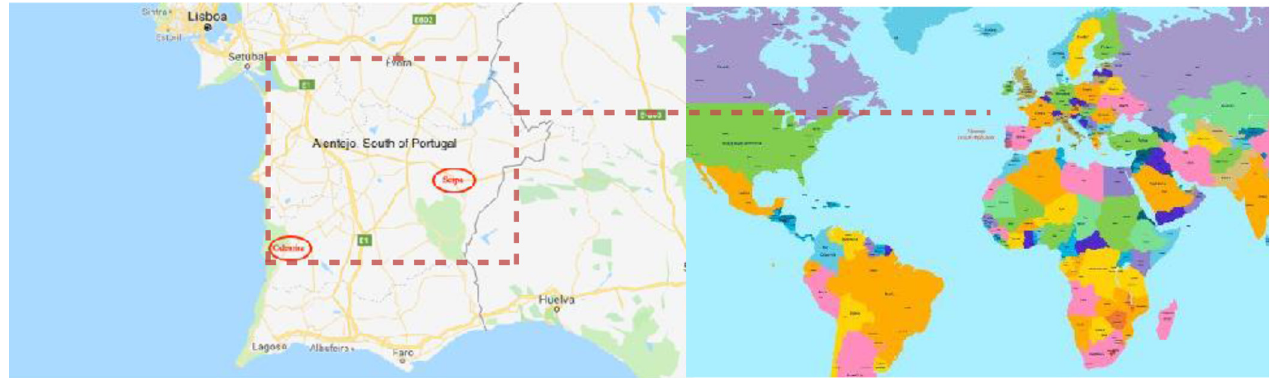
Fig. 1. Odemira and Serpa location in Alentejo, South of Portugal map. (West side of Europe) (cid:1) Image of Alentejo adapted from Google Maps and Mapa Mundi image Designed